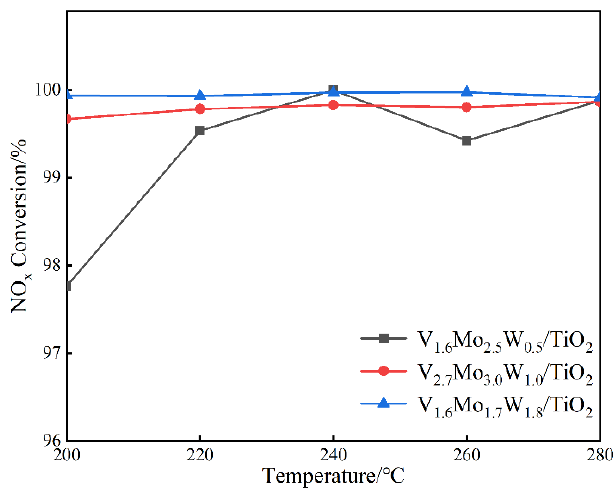
Figure 4. The NO x conversion of the three catalysts.